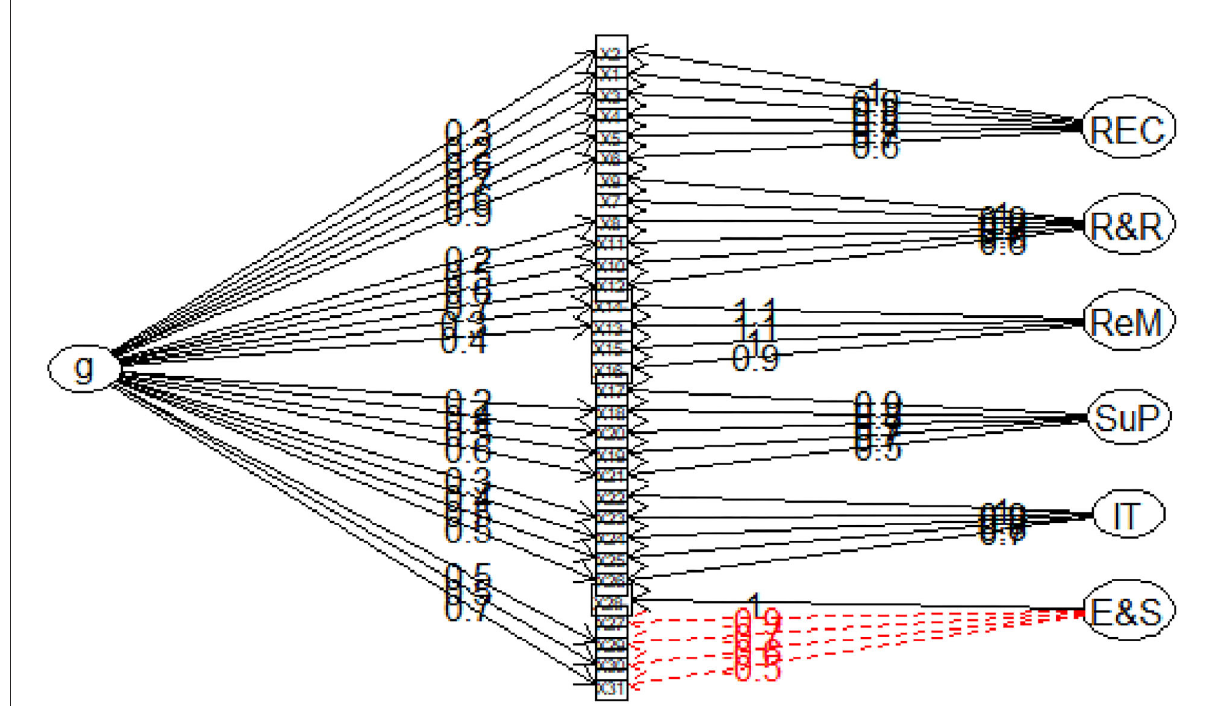
FIGURE4 Exploratory bifactor model for CHW-ISM scale. g, the conceptualized general factor indicative of communalities of all items; REC, “CHW Recruitment, Education and Certification” construct; R&R, “CHW Roles and Responsibilities” construct. ReM, “CHW Remuneration”; SuP, “CHW Supervision”; IT, “CHW Information management”; E&S, “CHW supplies and equipment” Items labels (x1–x31) correspond to items as listed in Table